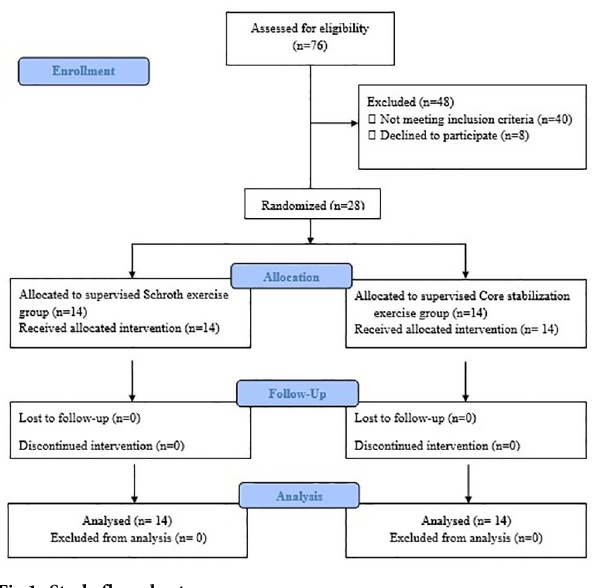
Fig 1. Study flow chart.